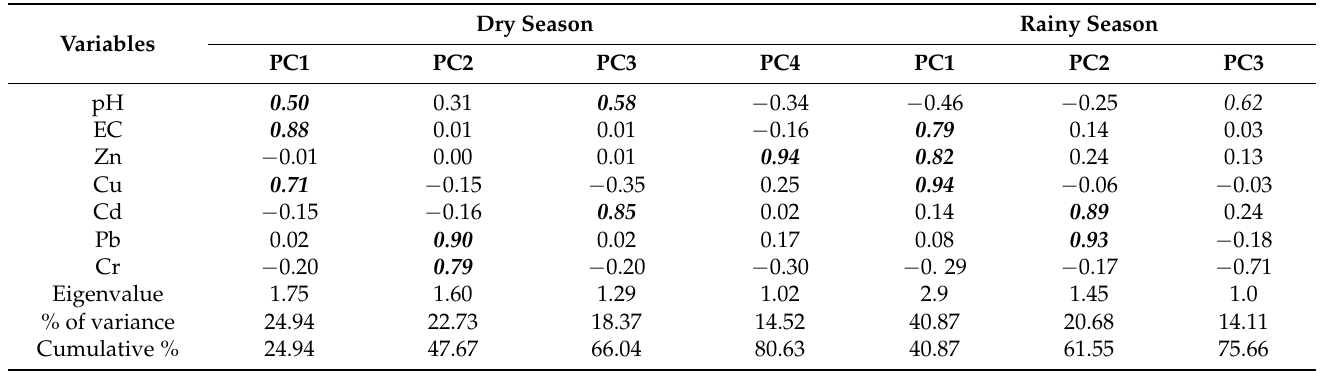
Table 3. Rotated principal component loadings of heavy metal, pH, and EC values in the Fuhe River water.